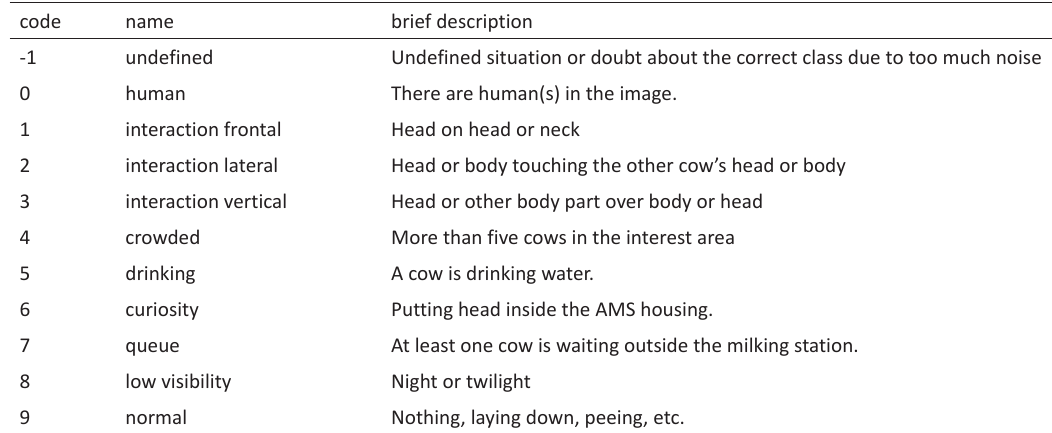
Table 1. The classes used in labeling in their order of priority decreasing from top to